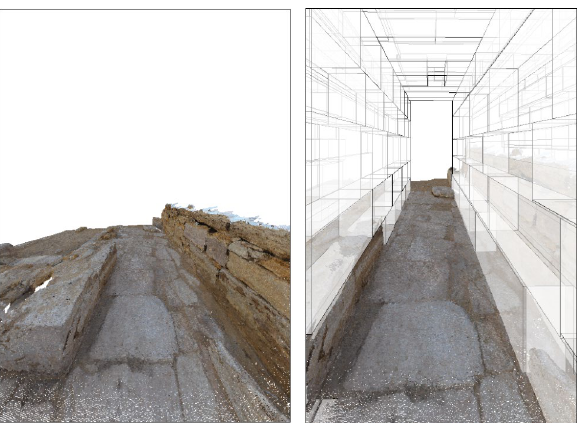
Figure 12: The inner corridor from laser scanner survey (on the left side) and its virtual reconstruction (on the right